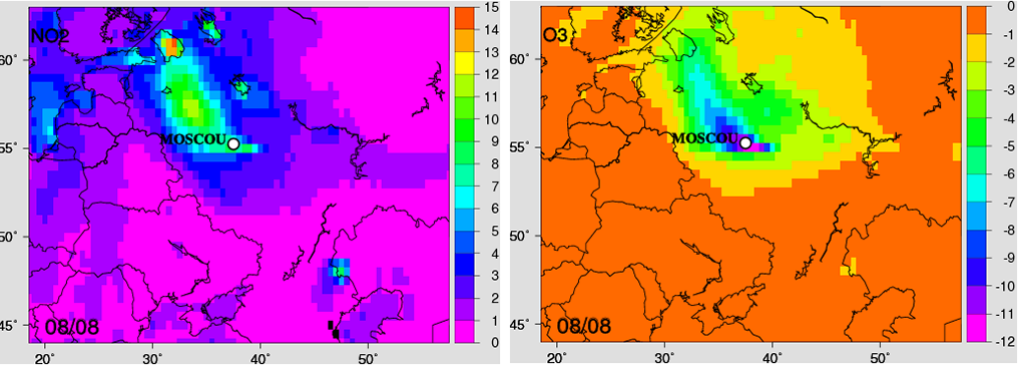
Figure 5. Geographic distribution of the daytime average percentage changes in the near-surface concentration of NO 2 (left) and O 3 (right) for the 8 August 2010, due to the presence of aerosols.